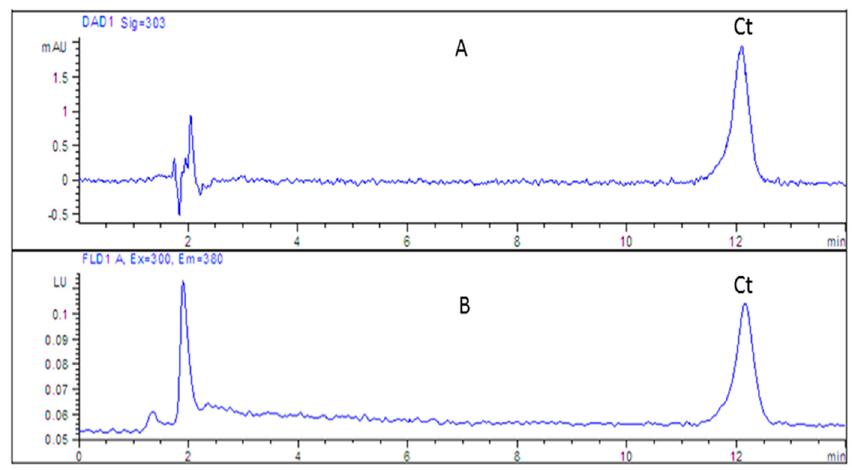
Figure 2. Chromatograms obtained for cytisine (Ct) standard (1 μ g/mL) using HPLC-DAD ( A ) and HPLC-FLD ( B ) techniques. Stationary phase: Luna 5 μ m, SCX 100A, 150 × 4.6 mm column; mobile phase: 15% ACN and 100 mM of formate buffer at pH 4.0.